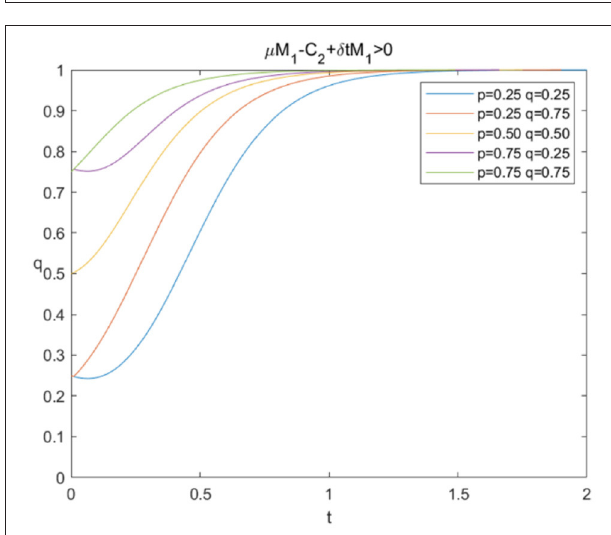
FIGURE 5 | Evolutionary stability strategy of e-commerce platforms when µ M 1 + δ ∗ tM 1 − C 2 >